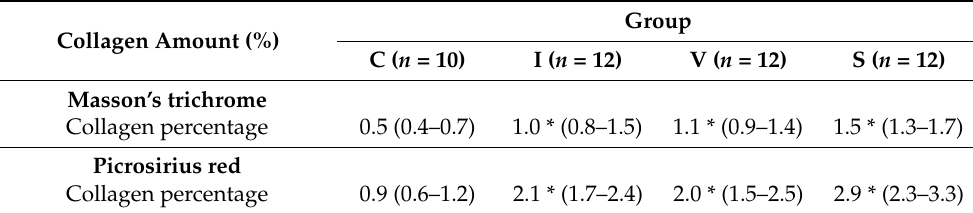
Table 6. Collagen percentage in quadriceps muscle of rats that analyzes from Masson’s trichrome staining and Picrosirius red staining on Day